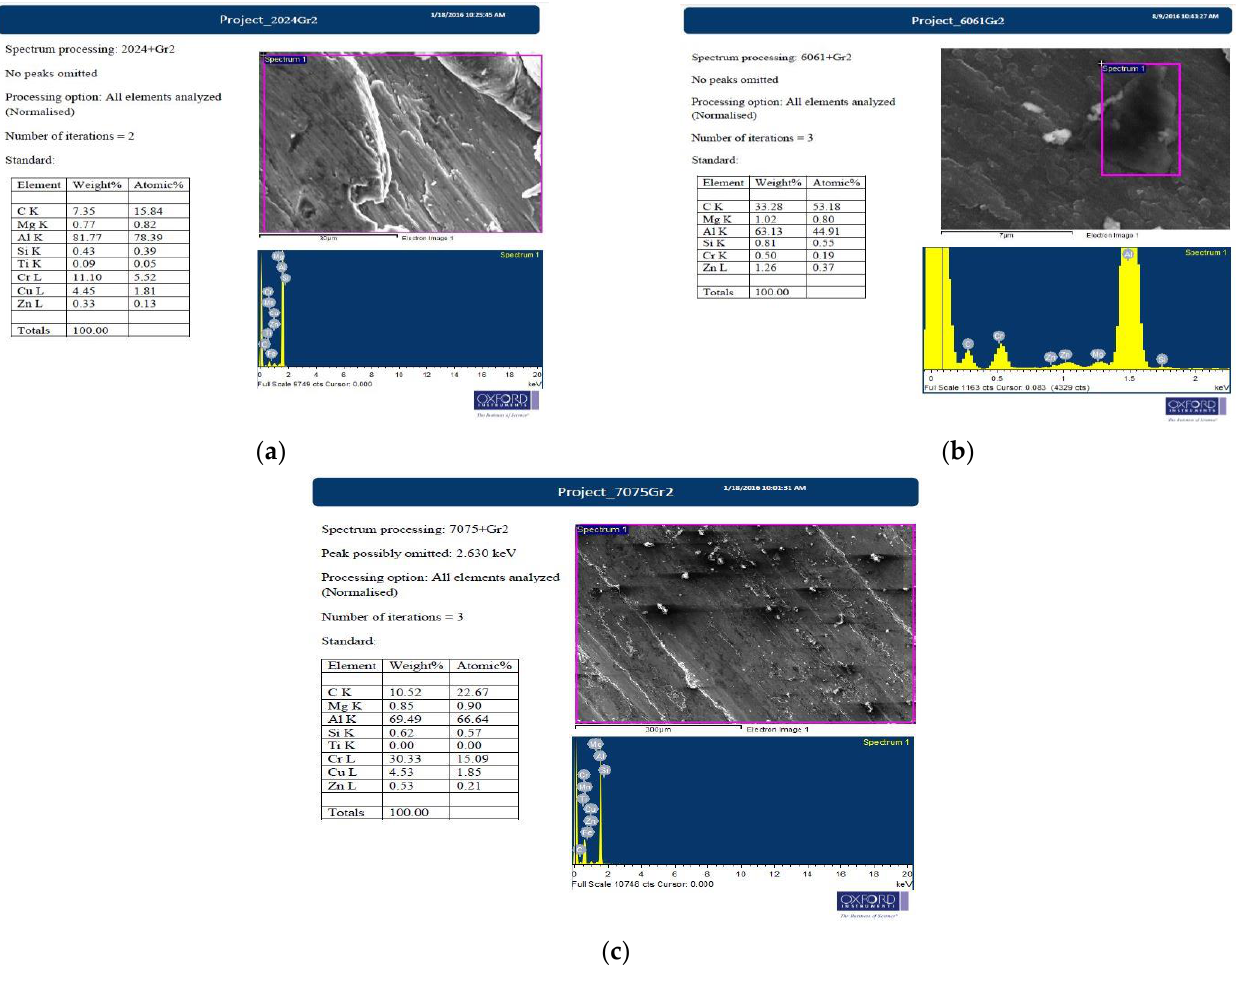
Figure 10. EDS analyzed elemental composition of fabricated composites ( a ) AA2024 + 2%Gr, ( b ) AA6061 + 2%Gr and ( c ) AA7075 + 2%Gr. ( b ) AA6061 + 2%Gr and ( c ) AA7075 +